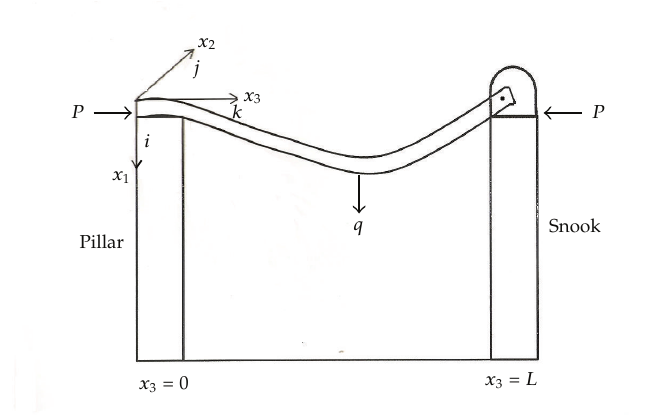
Figure 4: Beam with end at x (cid:5) 0 clamped and end x (cid:5) L simply supported (cid:3) hinged (cid:4)